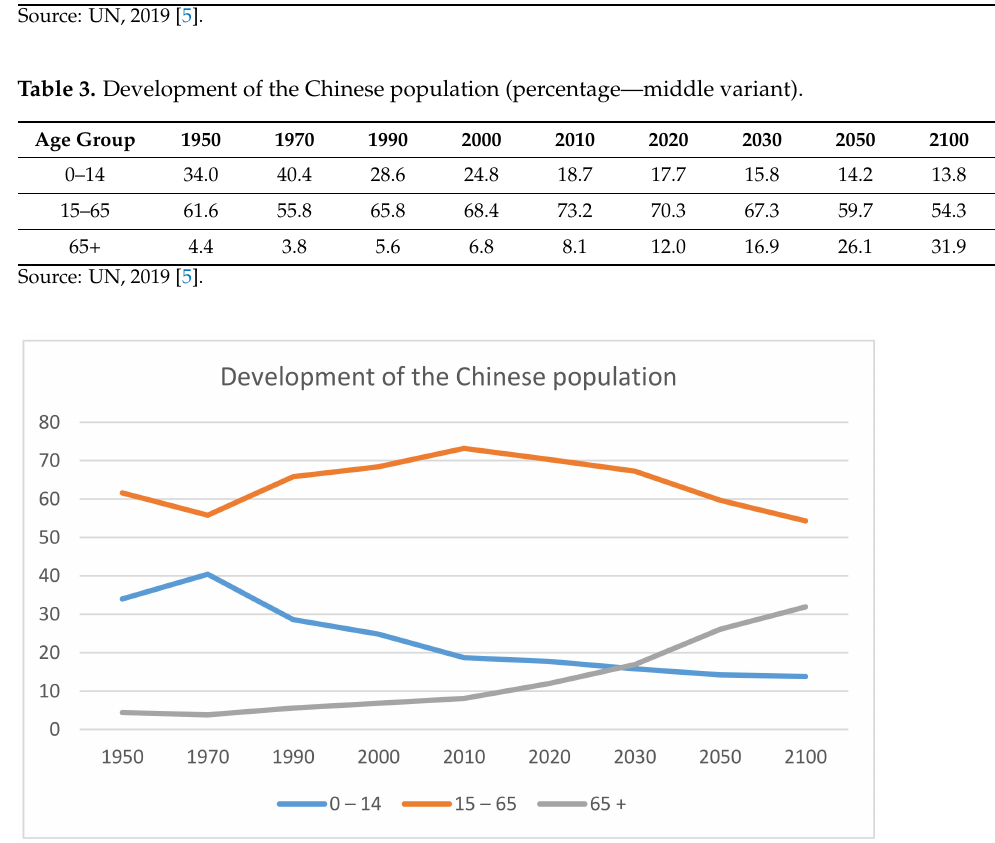
Figure 1. Development of the Chinese population. Source: authors processing according to UN, 2019